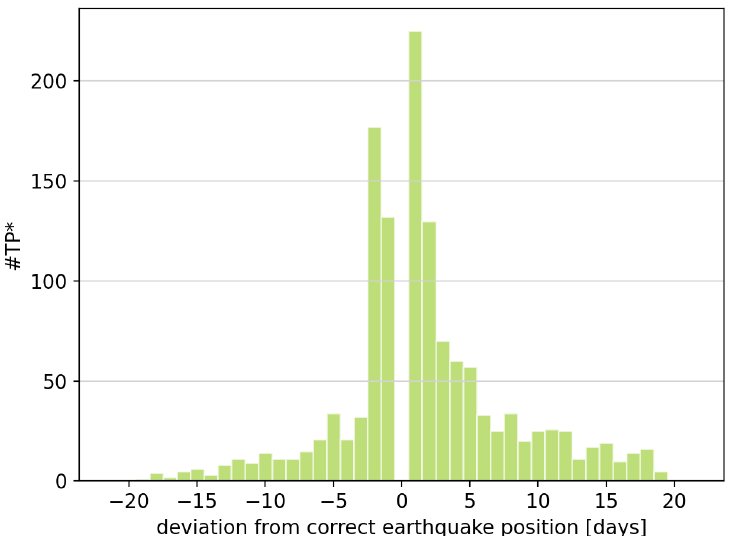
Figure 7. Deviation of correct earthquake position of TP* of the testing